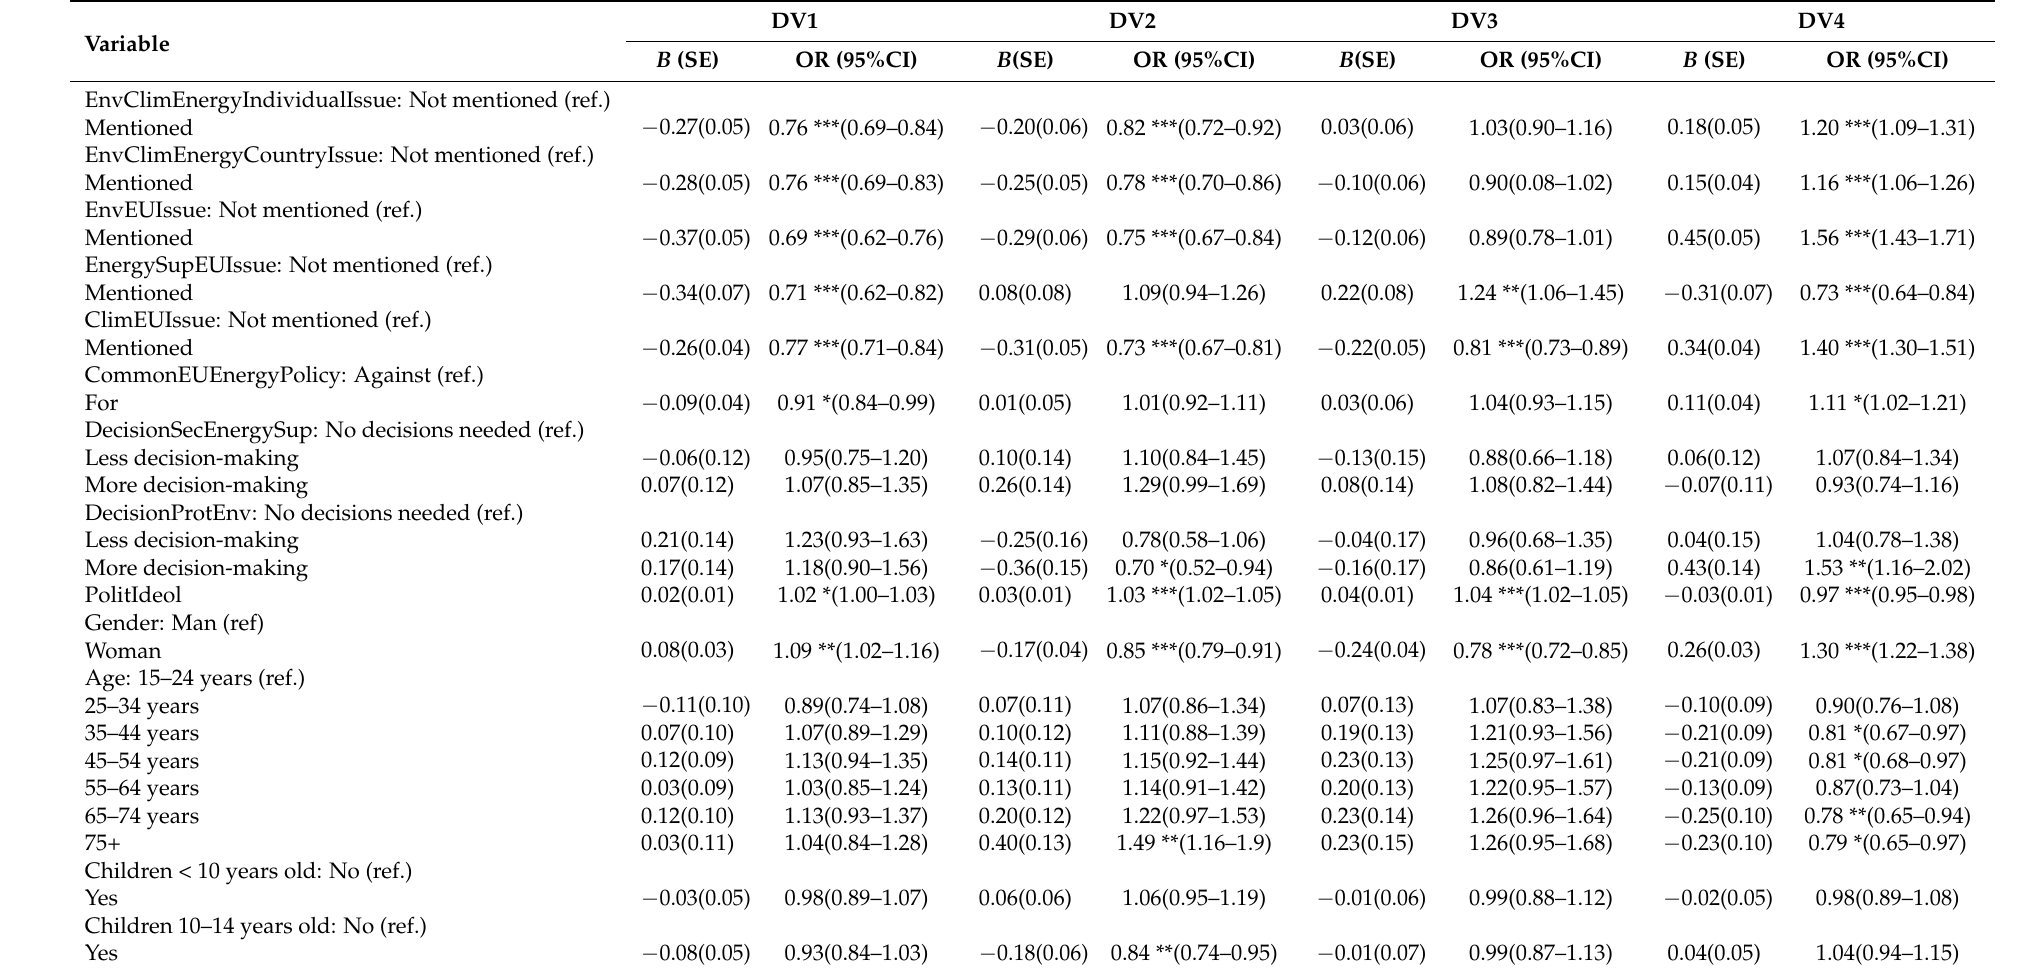
Table 4. Binary logistic regression analysis